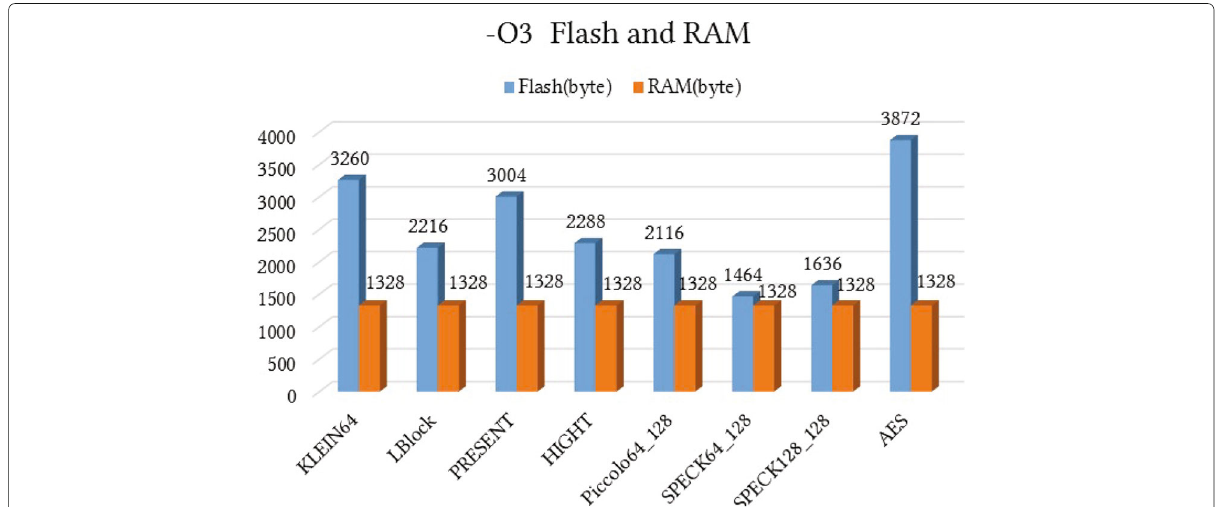
Fig. 10 Memory usage of mode